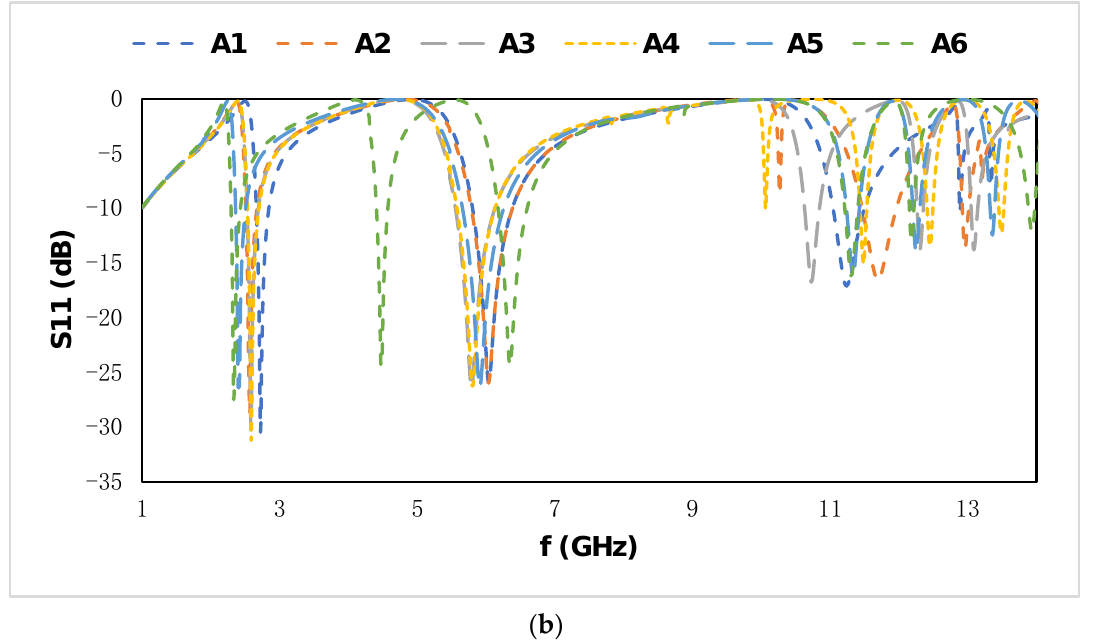
Figure 5. Transmission coefficient ( a ) and reflection coefficient ( b ) for different designs.